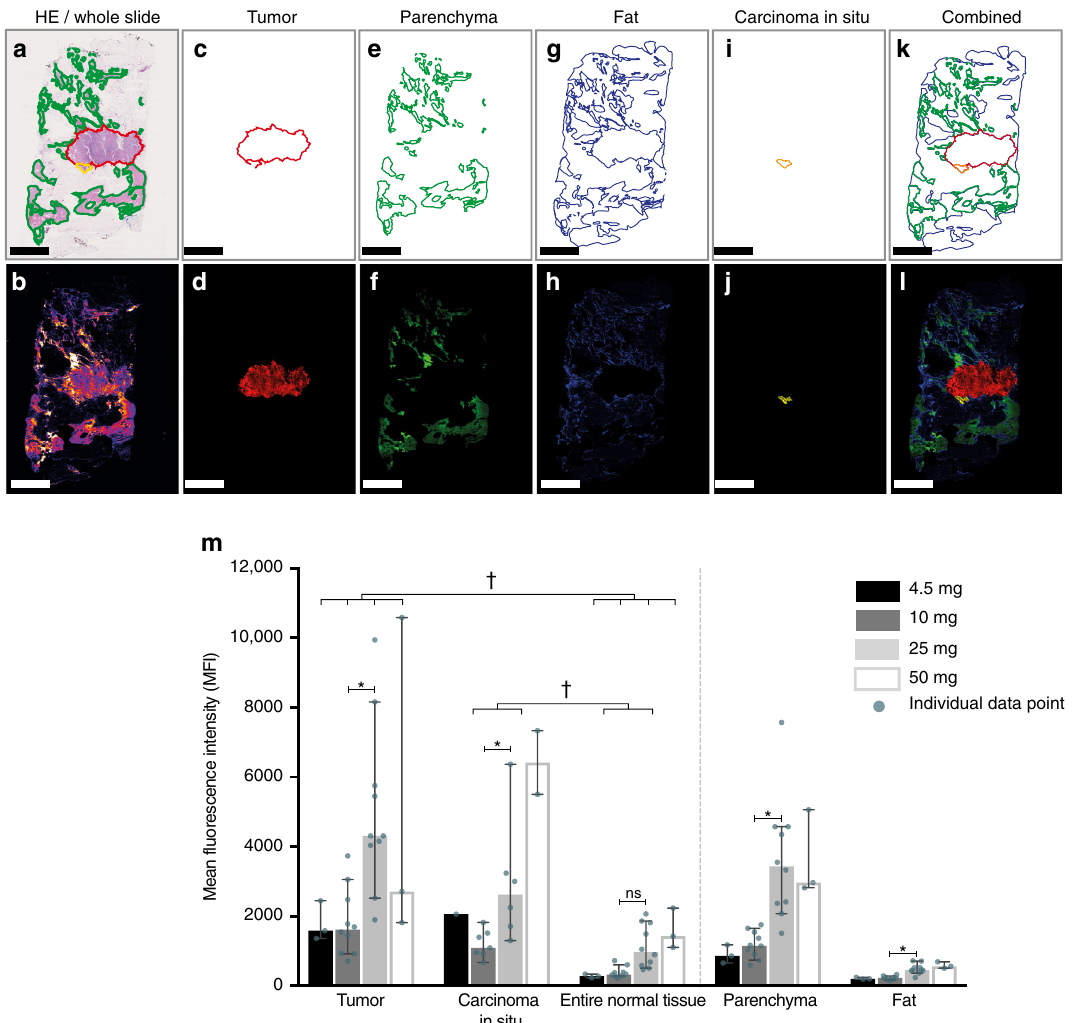
Fig. 3 Microscopic biodistribution in breast cancer tissue of bevacizumab-800CW based on micro-segmentation analyses. The upper row shows a representative example of the region-of-interest per tissue type based on H/E staining. The lower row shows the corresponding pseudo color fl uorescence intensity image of each tissue type. In a , b the whole section is depicted, and in c , d the tumor area, e , f parenchymal breast tissue including collagen, g , h fat tissue, i , j carcinoma in situ tissue, and a combination of all tissue types in k , l . Mean fl uorescence intensities of all patients per dose group, per tissue type are shown in panel m . Asterisk denotes signi fi cant ( P < 0.05, Kruskal – Wallis test) values. Obelisk denotes signi fi cant ( P < 0.05, Mann – Whitney U -test) values. Bars are representing the median, error bars are representing 95% con fi dence interval. Scale bars represent